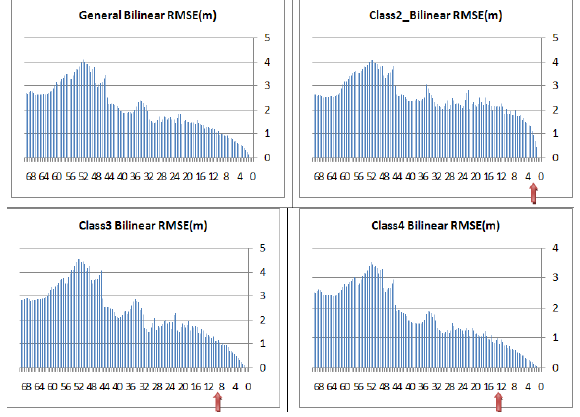
Figure9, Plots of precision changes in Bilinear interpolation in each increasing step. Arrows show the maximum bound of reasonable relation between grid spacing and errors (Horizontal axis: DEM grid spacing, vertical axis: amount of errors)